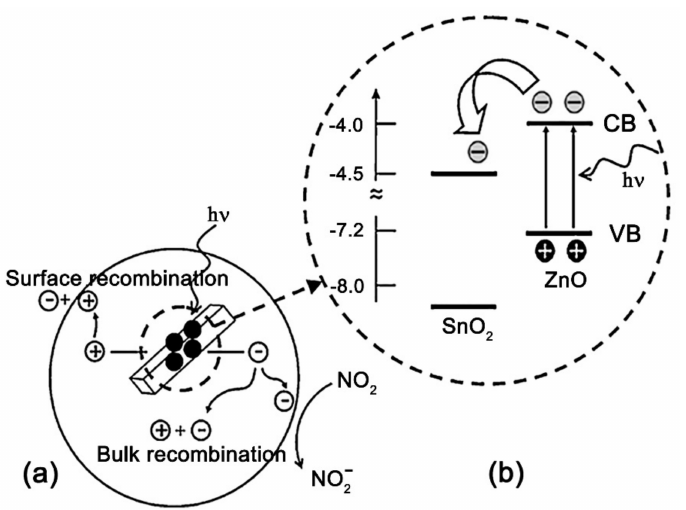
Figure 4. Schematic diagram: ( a ) the carriers transport with UV light stimulated, ( b ) energy band structure and electron–hole pair separation in the ZnO/SnO 2 heterostructure in the area marked with a dashed circle. Reprinted from [84] with permission from Elsevier, 2012. A short summary of literature data on the sensor signal of wide-gap oxides under UV and visible light activation toward various gases is presented in Table 2. Table 2. Sensor signal of wide-gap oxides in the detection of various gases when activated by ultraviolet and